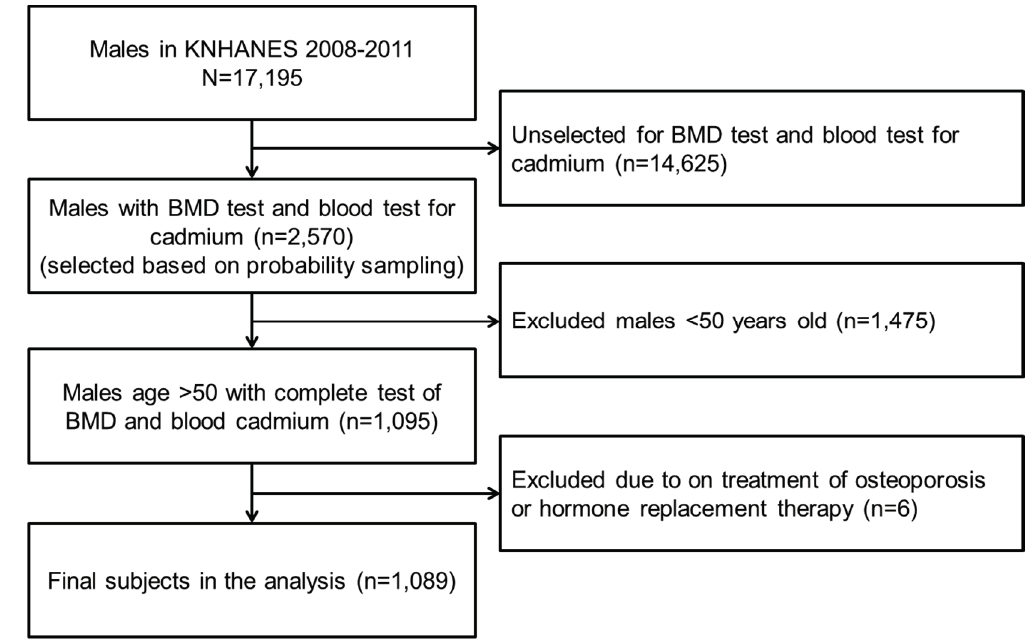
Figure 1. Flow diagram of subject inclusion and exclusion in the Korea National Health and Nutrition Examination Surveys (KNHANES)